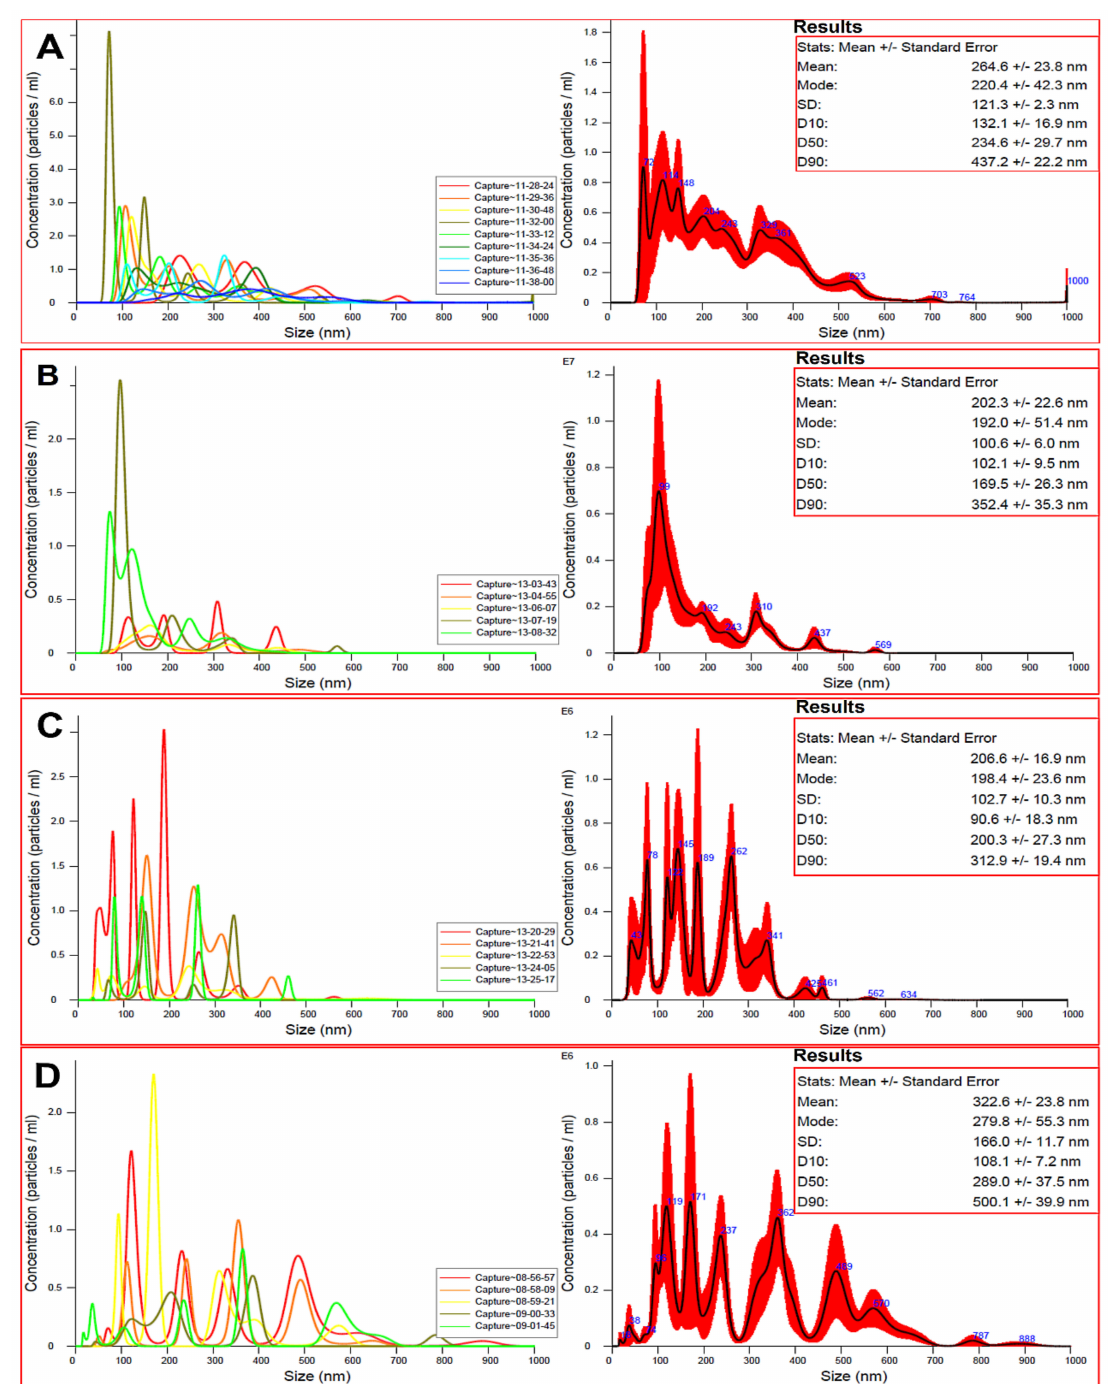
Figure 4. The particle size distribution determined by particle tracking analysis (PTA). ( A ) ZnO NPs; ( B ) ZnO NPs–NH 2 – COOH; ( C ) ZnO NPs–NH 2 –COOH–TRP; and ( D ) ZnO NPs–NH 2